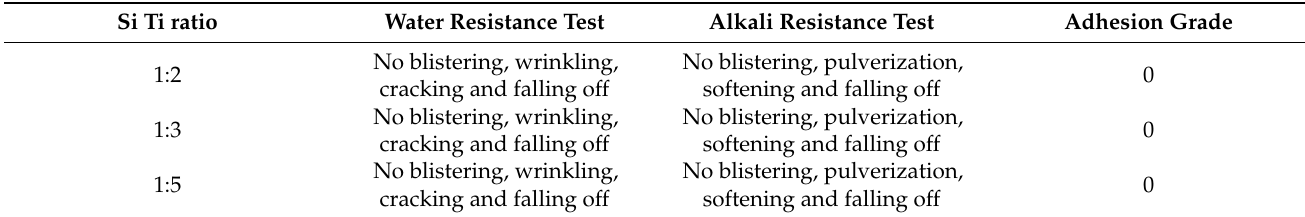
Table 2. Water resistance, alkali resistance and adhesion performance of coating. Si Ti ratio Water Resistance